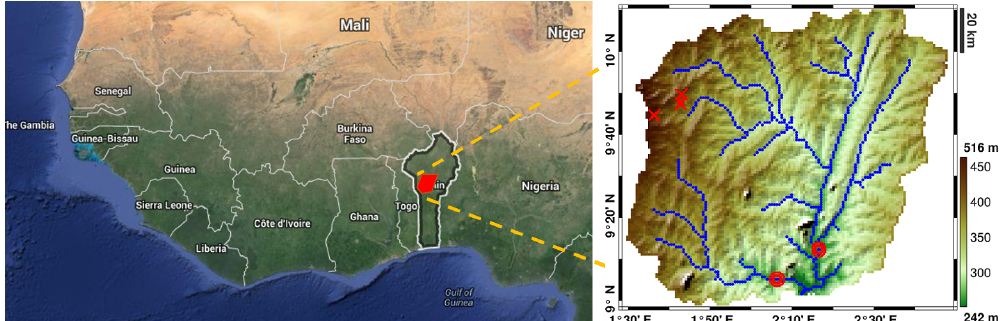
Figure 1. The Ouémé catchment is located in Benin, West Africa. Indicated on the right panel is the location of three soil moisture stations in the northwestern part (red crosses) where water table depth is also measured, and two streamflow sensors installed in the southern part (red circles, the outlet total streamflow being the sum of the two stations